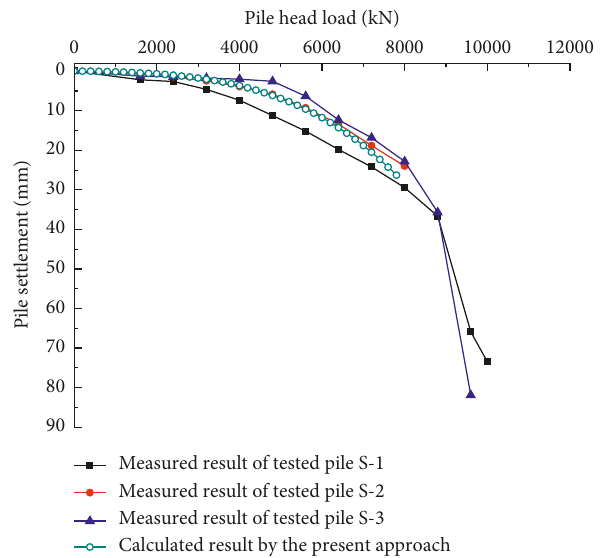
Figure 12: Comparison of load-settlement between the measured and computed results for a single